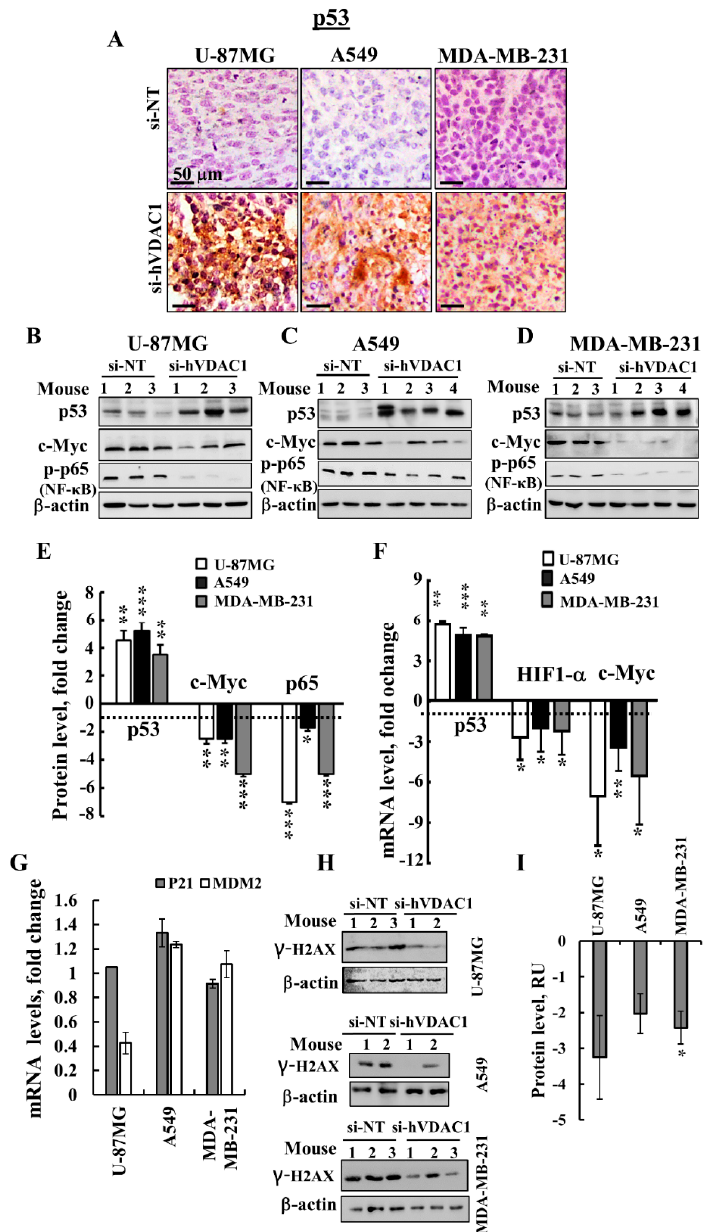
Figure 6. si-hVDAC1 treatment alters the expression levels of p53, HIF-1 α and c-Myc transcription factors and of phosphorylated NF- κ B/RelA, p65 in U-87MG-, A549- and MDA-MB-231-derived tumours. ( A ) Representative IHC staining of p53 in si-NT-TT or si-hVDAC1-TT sections derived from U-87MG, A549 and MDA-MB-231 xenografts. ( B – E ) Immunoblot analysis of p53, c-Myc and phosphorylated NF- κ B/RelA (p65) in si-NT-TTs and si-hVDAC1-TTs derived from U-87MG ( B ), A549 ( C ) and MDA-MB-231 ( D ) xenografts. Quantitative analysis of p53, c-Myc and p65 levels in U-87MG, A549 and MDA-MB-231 cell tumours is presented ( E ). ( F ) q-RT-PCR analysis of p53, HIF-1 α and c-Myc mRNA levels in U-87MG-, A549- and MDA-MB-231-derived tumours treated with si-hVDAC1, relative to those treated with si-NT. ( G ) q-RT-PCR analysis of p21 and MDM2 mRNA levels in U-87MG-, A549- and MDA-MB-231-derived tumours treated with si-hVDAC1, relative to those treated with si-NT. ( H , I ) Immunoblot staining ( H ) of γ -H2AX (phospho S139) using specific antibodies and their quantitative analysis (I) presented as relative units (RU); mean ± SEM ( n = 3 mice) are shown for si-NT-TTs or si-hVDAC1-TTs derived from U-87MG, A549 and MDA-MB-231 xenografts. Results are means ± SEM); p : * ≤ 0.05; ** ≤ 0.01; *** ≤ 0.001. Dashed line indicates the control